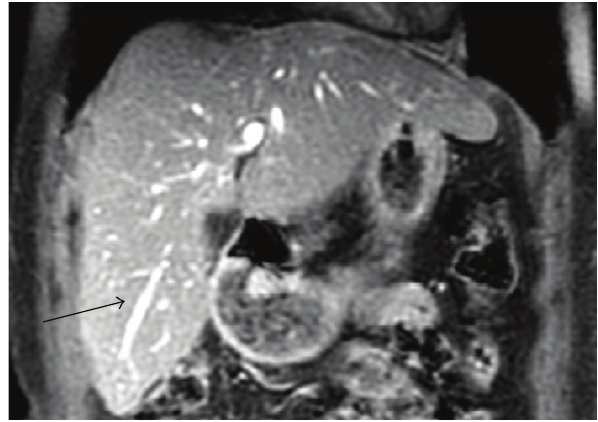
Figure 2: T1 weighted Magnetic Resonance image showing inferior right hepatic vein (arrow).